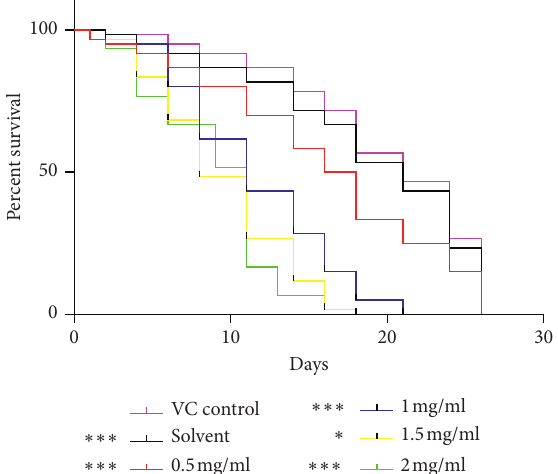
Figure 3: High concentrations of the essential oil of flesh fingered citron shorten the lifespan of wild-type C. elegans . Day 1 refers to the first day of treatment after adulthood. Results include at least three independent biological replicates. Statistical significance of the difference between the curves was demonstrated by a log-rank test using Kaplan − Meier survival analysis. Error bars represent the standard error, and differences compared to the solvent (0mg/ml, 0.1% DMSO) were considered significant at ∗ p < 0 . 05, ∗∗ p < 0 . 01, and ∗∗∗ p < 0 . 001 by one-way ANOVA and the LSD post hoc test.